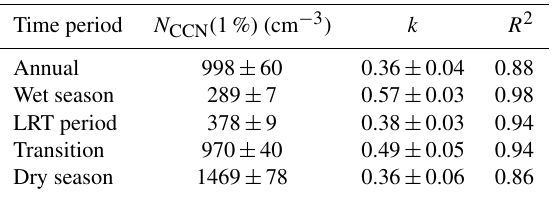
Table 5. Twomey fit parameters describing CCN spectra N CCN ( S ) vs. S as parametrization input data (compare to Figs. 10 and 11a, c). Fit parameters are provided for annually averaged CCN spectra and resolved by seasons.